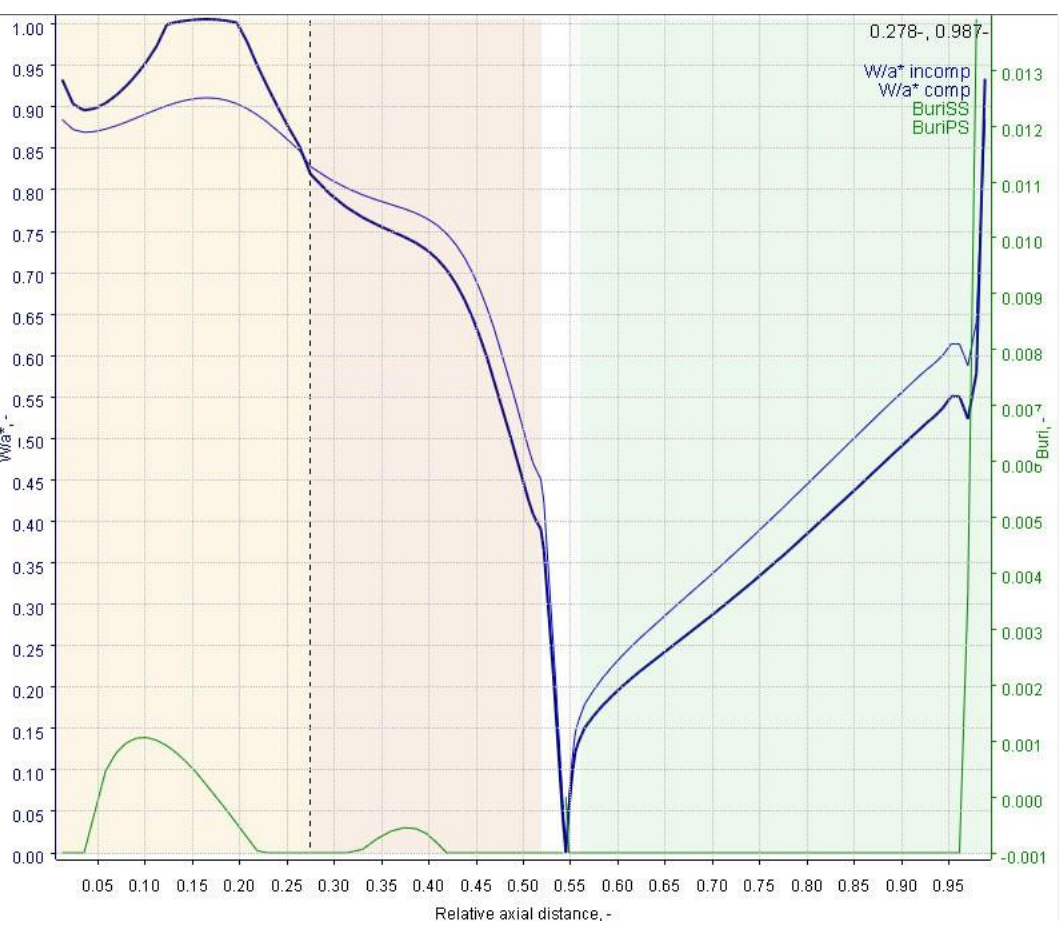
Figure 8. Streamwise Mach numbers (blue) and Buri criterion values (green) over a stator profile section. (“comp”: compressible; “incomp”: incompressible; “SS”: surface side; “PS”: pressure side).